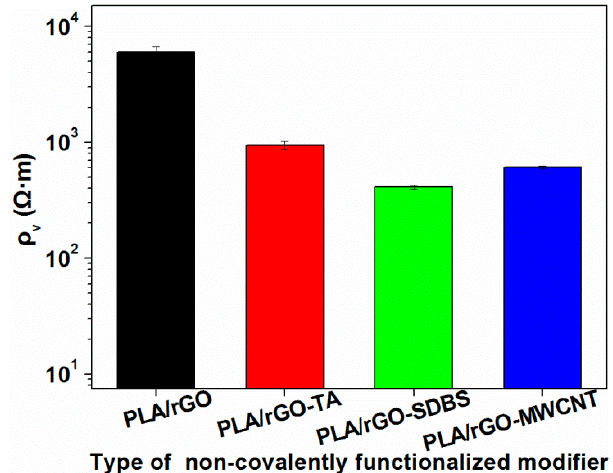
Figure 10. Electrical resistivity of the modified composites.